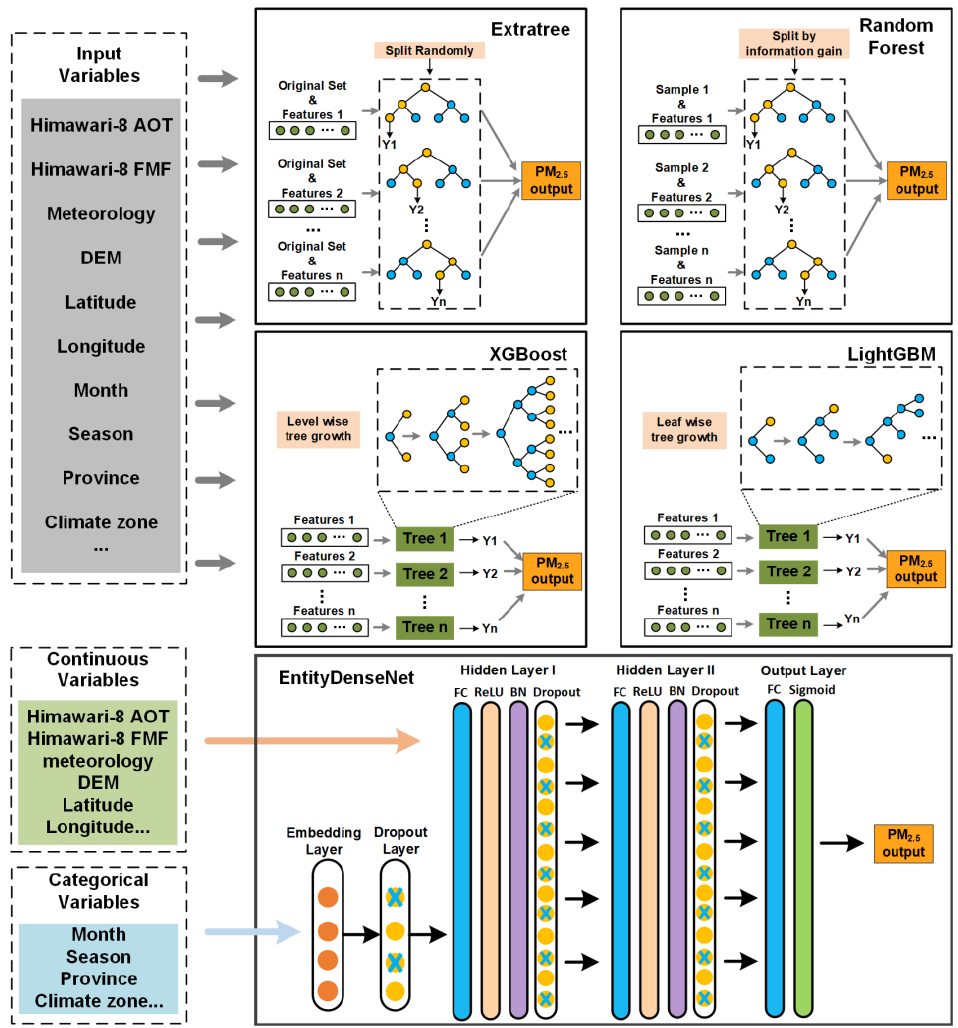
Figure 2. Schematic diagrams of the four traditional machine learning models (Extratree, Random Forest, XGBoost, and LightGBM) and the deep learning model (EntityDenseNet) used in this study.